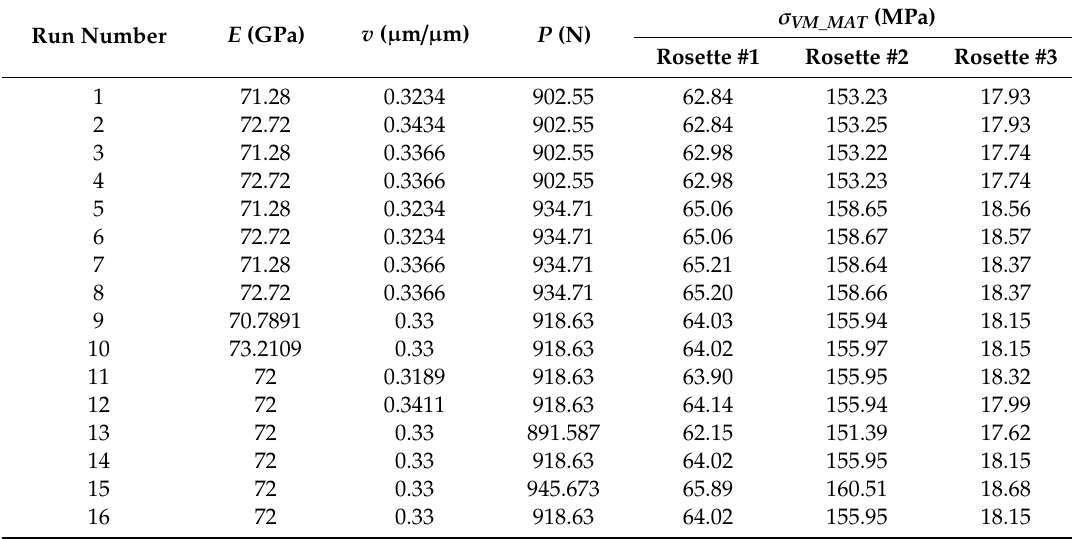
Table 8. Summary of the simulations results based in Central Composite Design (CCD) of the materials properties and